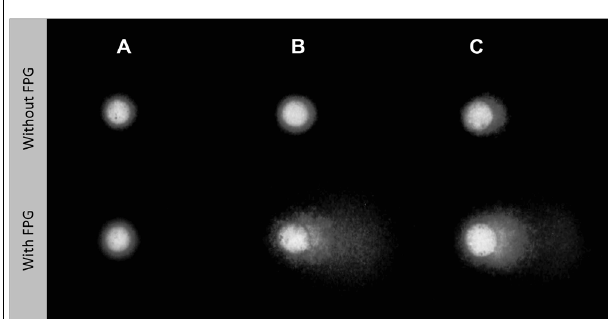
FIGURE 2 | Representative HepG2 Comet nucleoids treated without or with formamidopyrimidine-DNA glycosylase (FPG), to reveal oxidative damage to DNA. (A) Negative control (dimethyl sulfoxide, DMSO only). (B) Cells exposed to the crude extract from sediment S1 [100 mg sediment equivalent (SEQ)/mL]. (C) Cells exposed to the crude extract from sediment S2 (200 mg SEQ/mL).